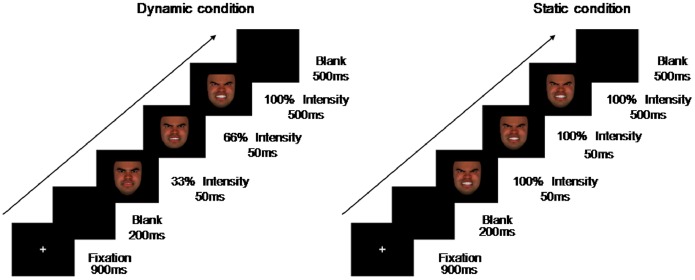
The sequence of events in a trial showing emotional facial expressions of anger in static (right) and dynamic (left) presentation modes.